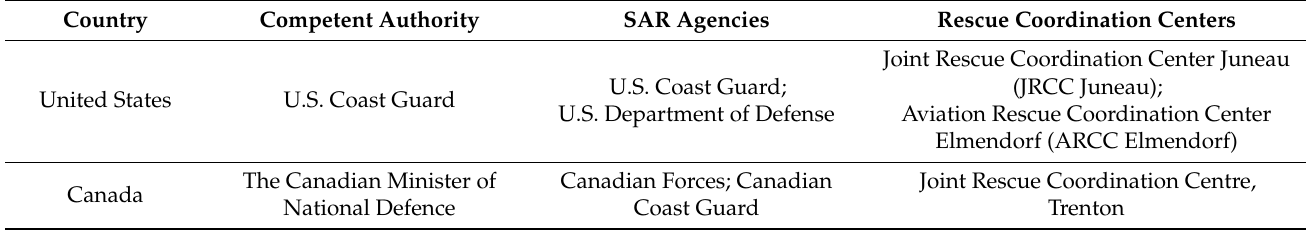
Table 1. Summary table of SAR agreement.